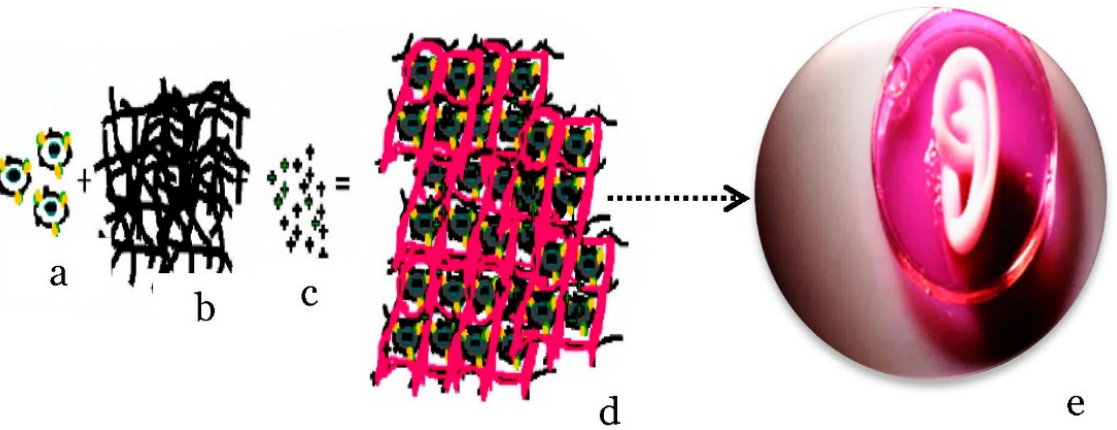
Figure 7. Tissue generation from cell to organ; cell ( a ), scaffold ( b ), bioactive factors ( c ), tissue engineering construct ( d ), and synthetic organ ( e ).